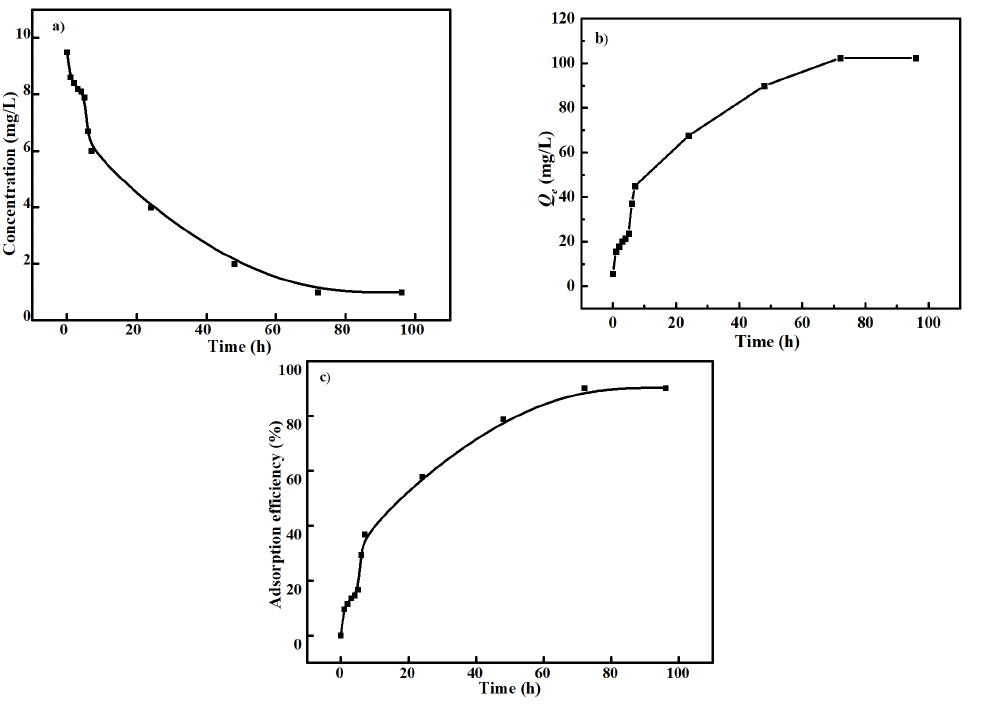
Figure 10. The Cd 2+ adsorption concentration ( a ), adsorption capacity Q e ( b ), and adsorption efficiency ( c ) of the carbonized ZIF − 8@PAN nanofiber membrane under the conditions of pH of 7.5 and water bath temperature of 35 °C.